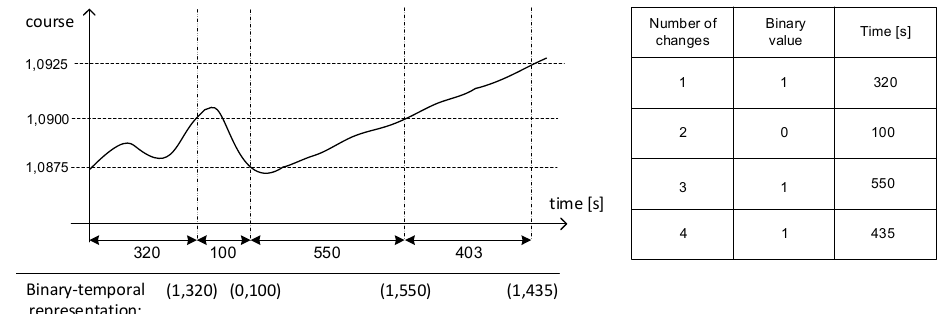
Figure 6. Performance of the algorithm for constructing binary-temporal representation for the discretization unit of 20 pips.